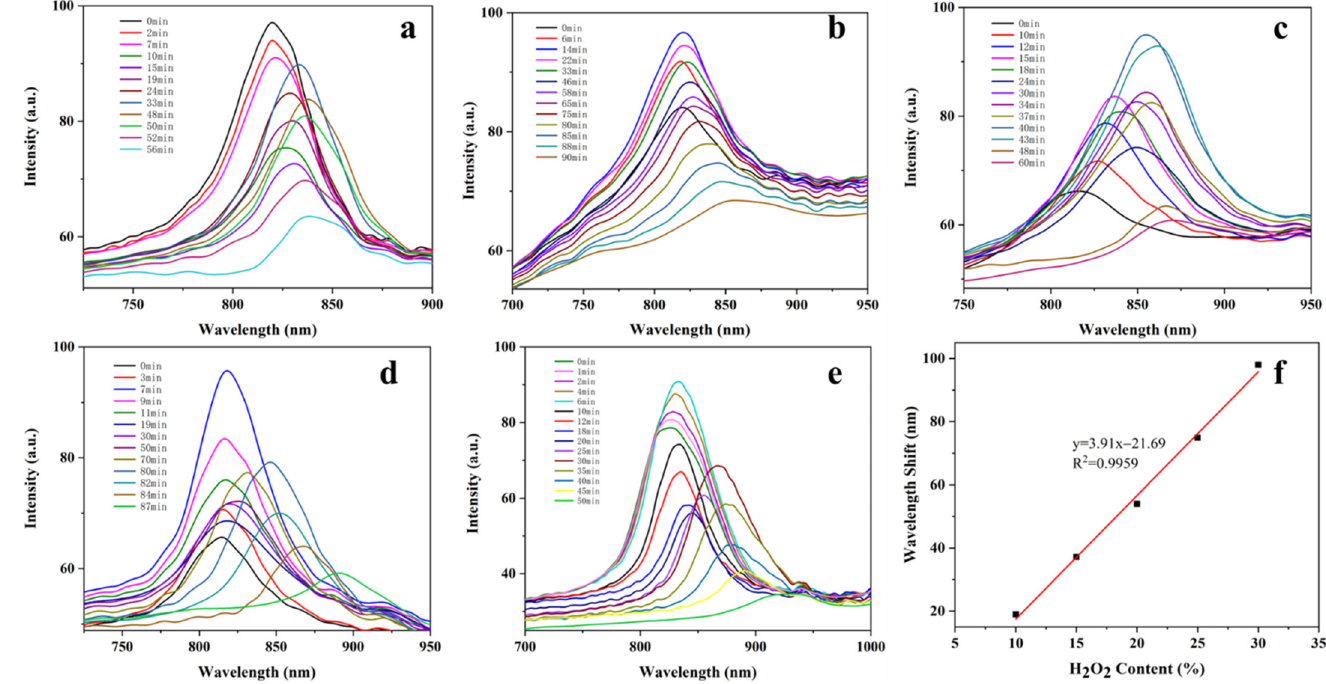
Figure 6. The maximum redshift of photonic crystal hydrogel with 15% BSP content in different concentrations (10% ( a ), 15% ( b ), 20% ( c ), 25% ( d ), 30% ( e )). ( f ) The linear relationship between the maximum redshift of photonic crystal hydrogel and concentration of H 2 O 2